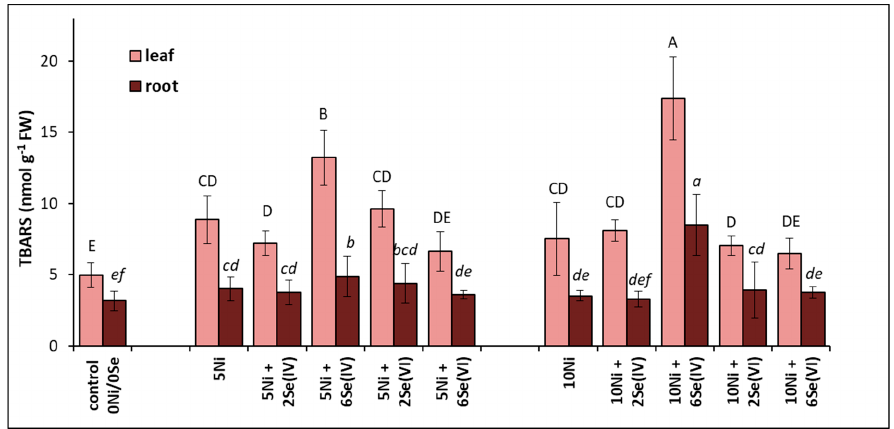
Figure 3. Effect of Se supplementation on the lipid peroxidation (expressed as the TBARS concentration) of Ni-exposed lettuce after 14 days of exposure. Data are means ± SD ( n = 6). Means for individual organs followed by the same letter are not significantly different ( p < 0.05, Tukey’s test).